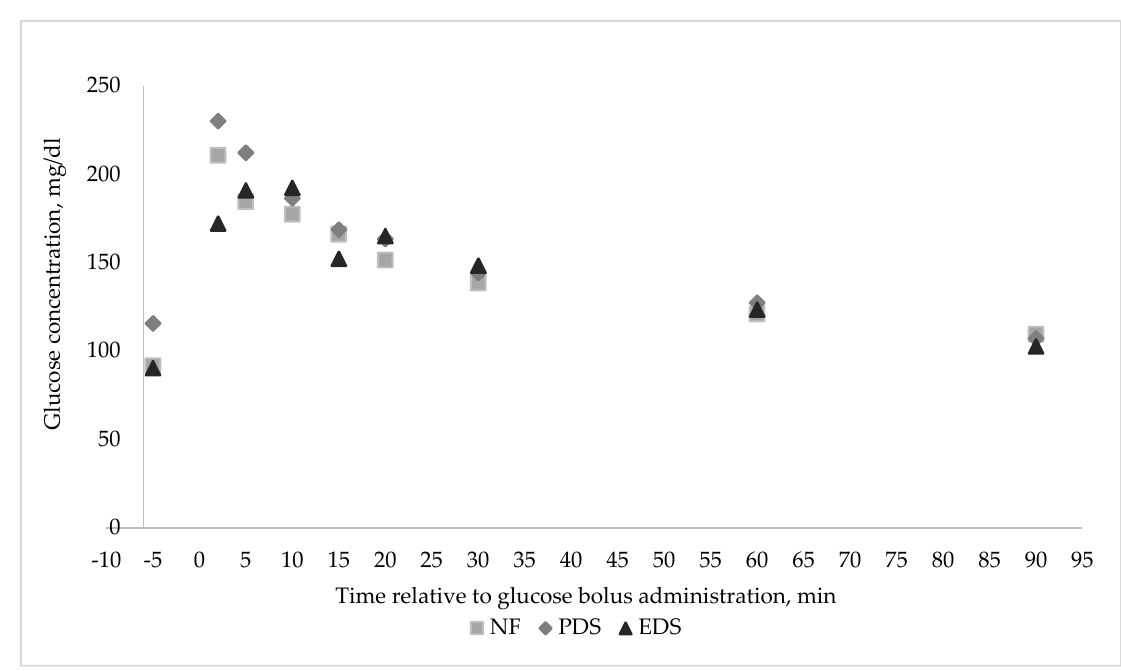
Figure 5. Effect of a fatty acid enriched diet during the last 50 days of gestation on plasma ghrelin concentrations during the glucose tolerance test on offspring during the finishing period (18 lambs; 2 sex and 3 dam treatments). Treatments of ewes supplemented with Ca salts of MUFA (PDS; EnerGII, Virtus Nutrition LLC, Corcoran, CA), PUFA (EDS; Strata G113, Virtus Nutrition LLC, Corcoran, CA), or no supplementation (NF) during the last 50 days of gestation. Data are presented as the LSmean of fatty acids × Time ( p = 0.29; standard error of the mean = 205.43). No difference ( p ≥ 0.20) for FA, Time, Sex, Time × Sex, FA × Sex, and FA × Time × Sex.